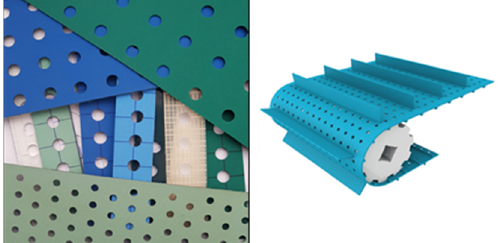
Figure 1. Multilayer polymer composite perforated belts used in vacuum belt transportation